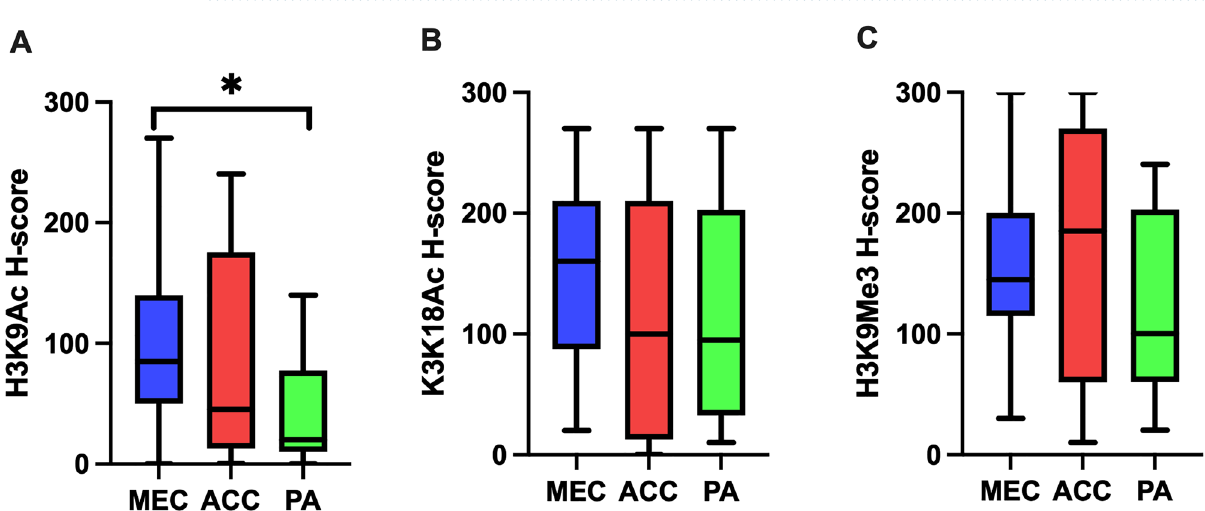
Figure 2. Level of histone H3 modifications in salivary gland neoplasms. ( A ) H3K9Ac; ( B ) H3K18Ac; ( C ) H3K9Me3. *Represents statistically significant difference at p <